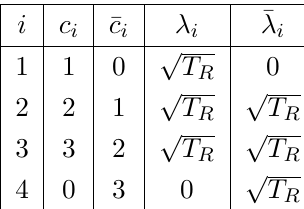
Figure 2 . Diagrammatic representation of colour (cid:13)ow basis states and their inner products. The left half of the (cid:12)gure shows three out of the six basis tensors required for a qgg (cid:22) q leg content, where the grey arrows indicate how leg labels i = 1 ; : : : ; 4 are mapped onto colour and anti-colour indices (see also table 1). The right hand part of the (cid:12)gure illustrates how inner products, i.e. elements of the scalar product matrix, relate to powers of N depending on how many loops are formed after contraction (see eq. (3.2)).